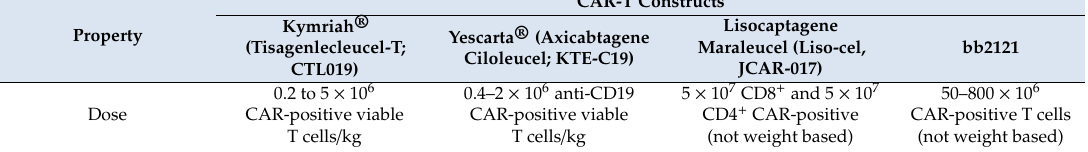
Table 4. Cont. CAR-T